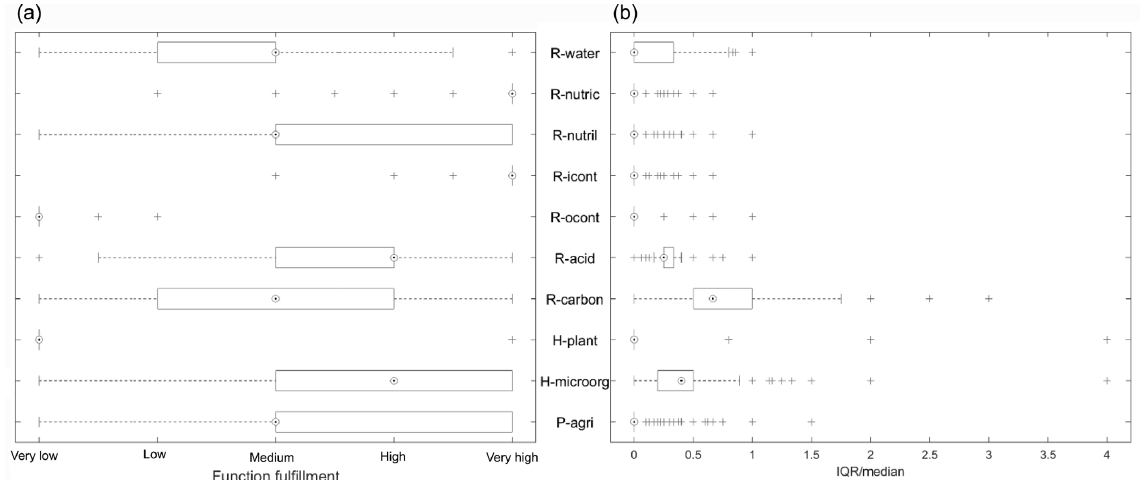
Figure 3. General overview of the resulting range of SFF scores for the 10 mapped soil sub-functions (a) , and of their coefficient of variation (b) expressed as the ratio of the interquartile range (IQR) and the median of the SFF scores for each raster cell. Circles with dots indicate the median coefficient of variation of the SFF scores across the case study